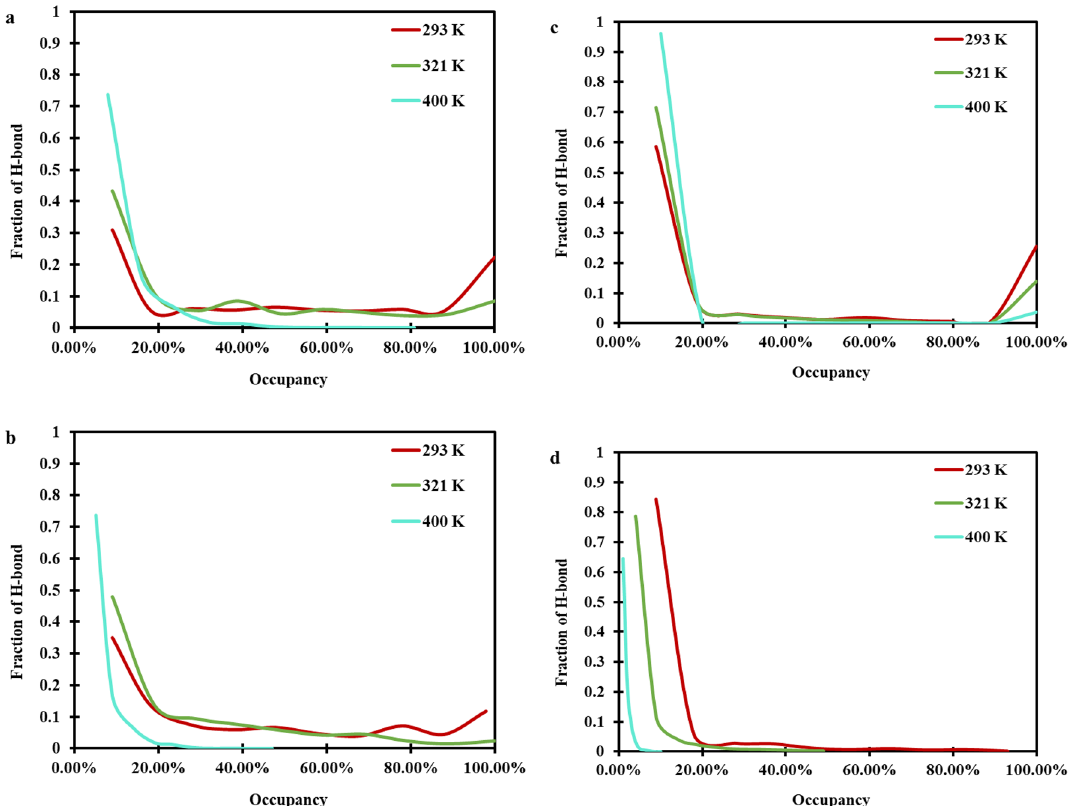
Figure 5. Fraction of hydrogen bond percent occupancies for ( a ) Cl – –Phpr (Cl-H4), ( b ) Cl – –choline